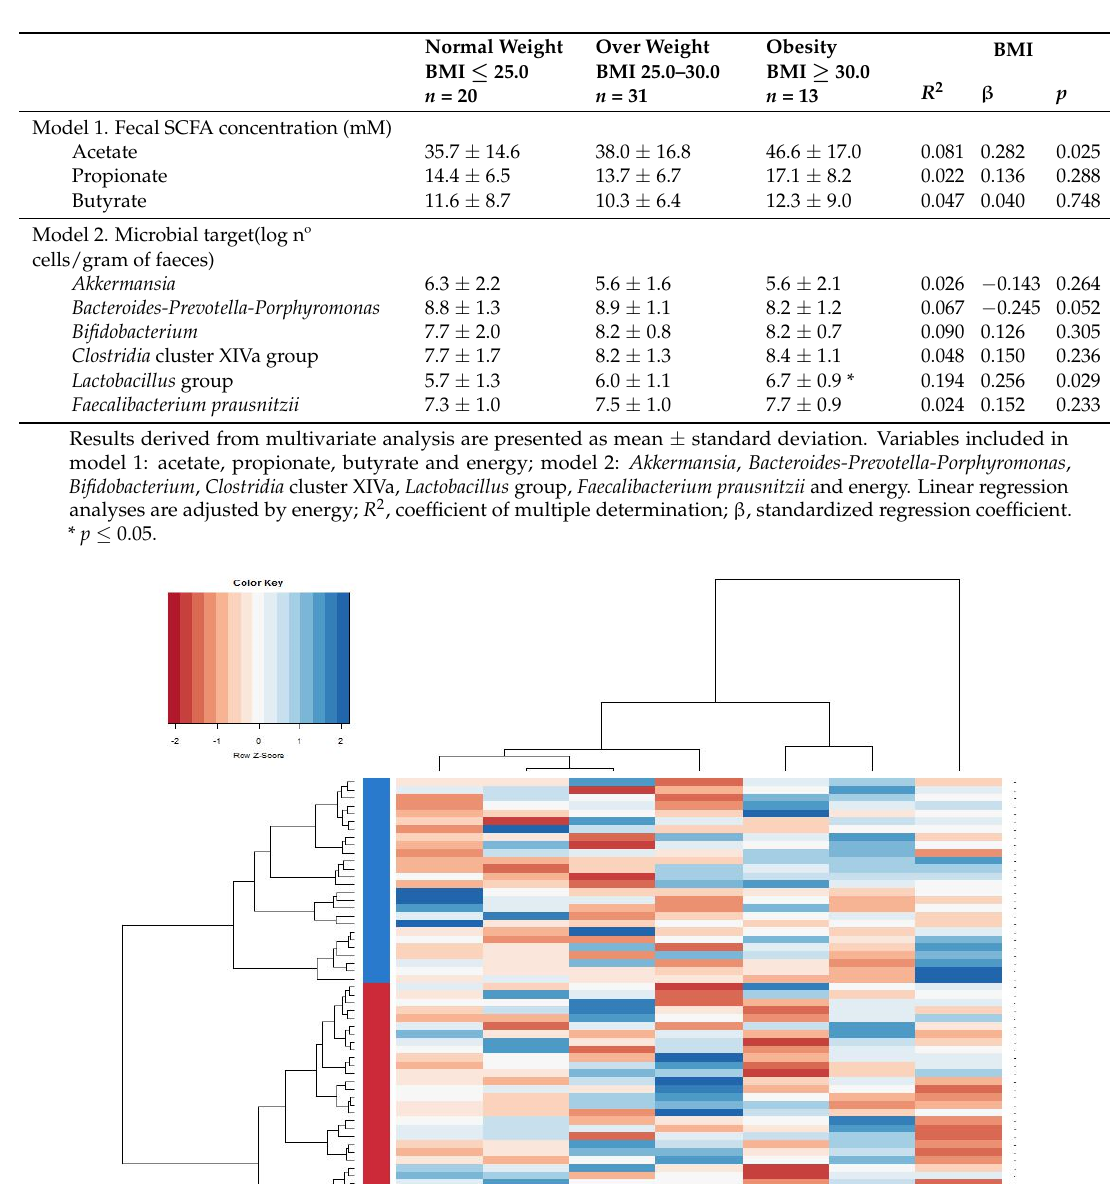
Table 3. Differences in fecal short chain fatty acids (SCFA) concentration and major microbial groups according to BMI (kg/m 2 ) and results of linear regression analyses to estimate their association with BMI.